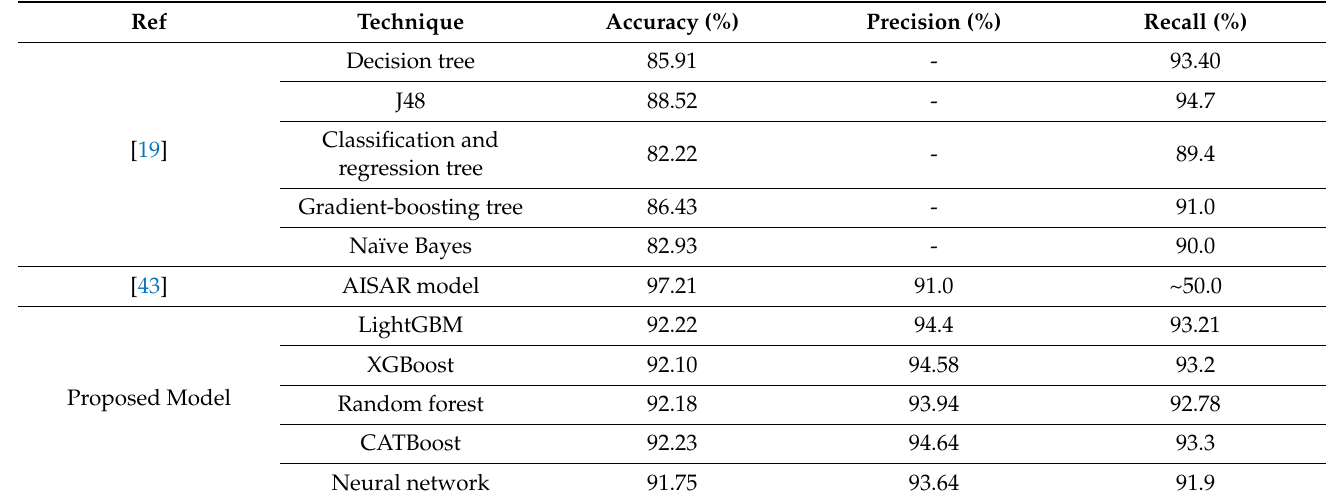
Table 5. Comparison between References [19,43] and Our